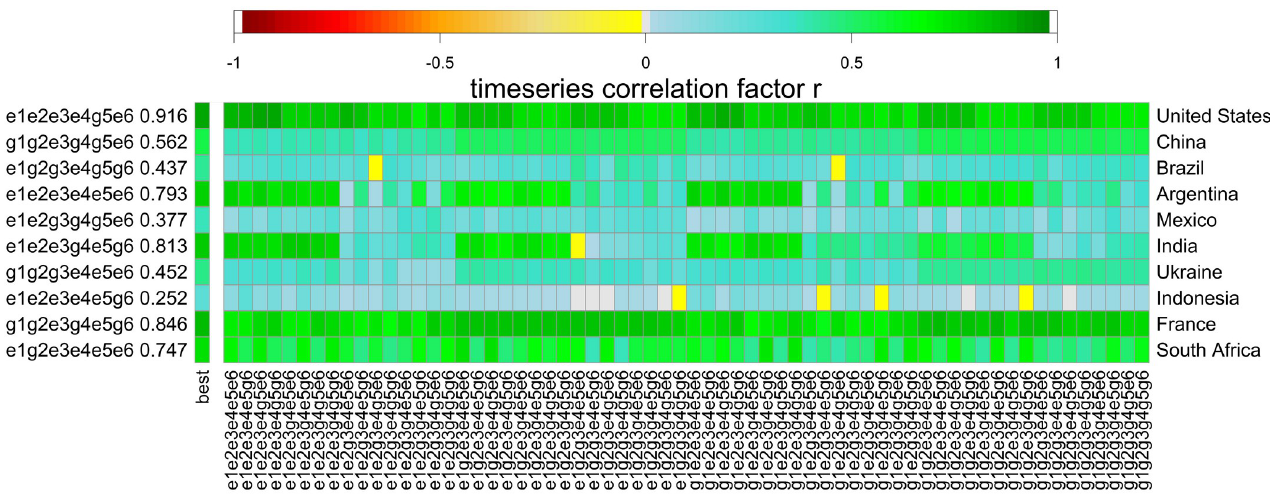
Fig 9. Time-series correlation coefficients against reported detrended yields for all EPIC-IIASA / GEPIC setup combinations. Results are shown for the top ten maize producing countries. GGCM names and r values are shown for the best performing setup in each country. 1 = cultivar distribution, 2 = soil parameters, 3 = soil handling, 4 = nutrient cycling coefficient, 5 = hydrologic coefficients, and 6 = management. e = EPIC-IIASA and g = GEPIC.